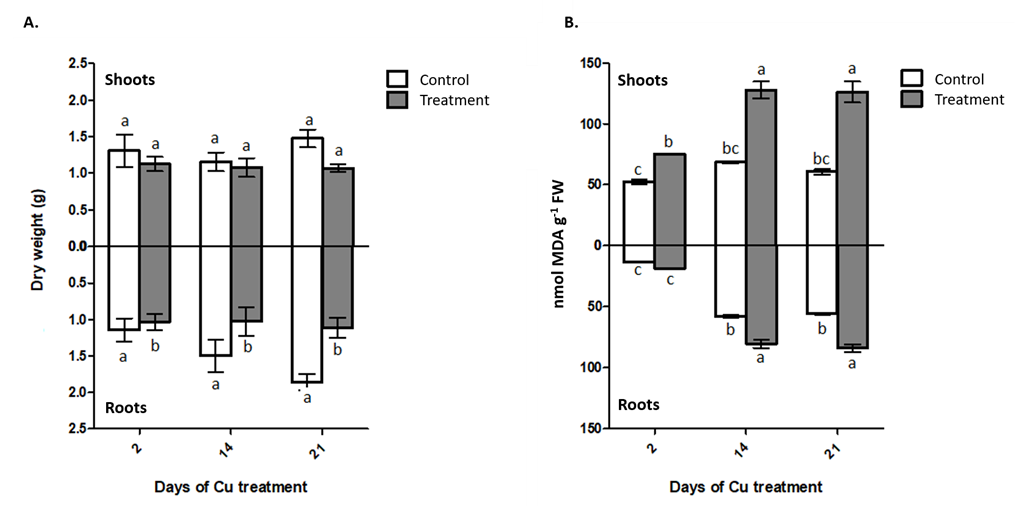
Figure 1. Dry matter and lipid peroxidation of Imperata cylindrica. ( A ) Dry matter production in shoots and roots; ( B ) Lipid peroxidation in shoots and roots. Where, control (without Cu applied) and treatment (300 mg Cu kg −1 substrate). Different lowercase letters indicate statistic difference according Tukey’s multiple range test ( p < 0.05). Data are expressed as mean ± SE, n = 4.